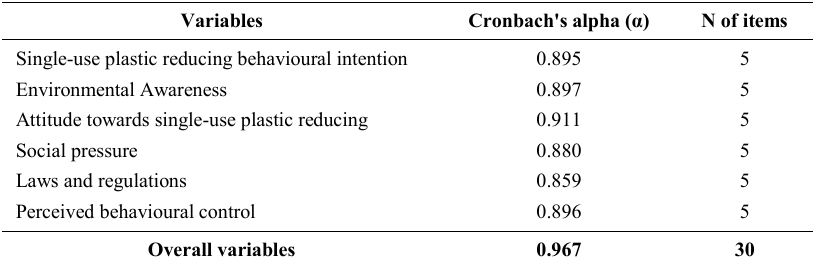
Table 1. Reliability Statistics.